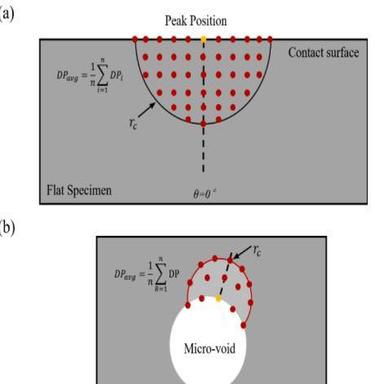
A schematic diagram of TCD method: (a) TCD applied at contact surface and (b) TCD applied at edge of micro-void.